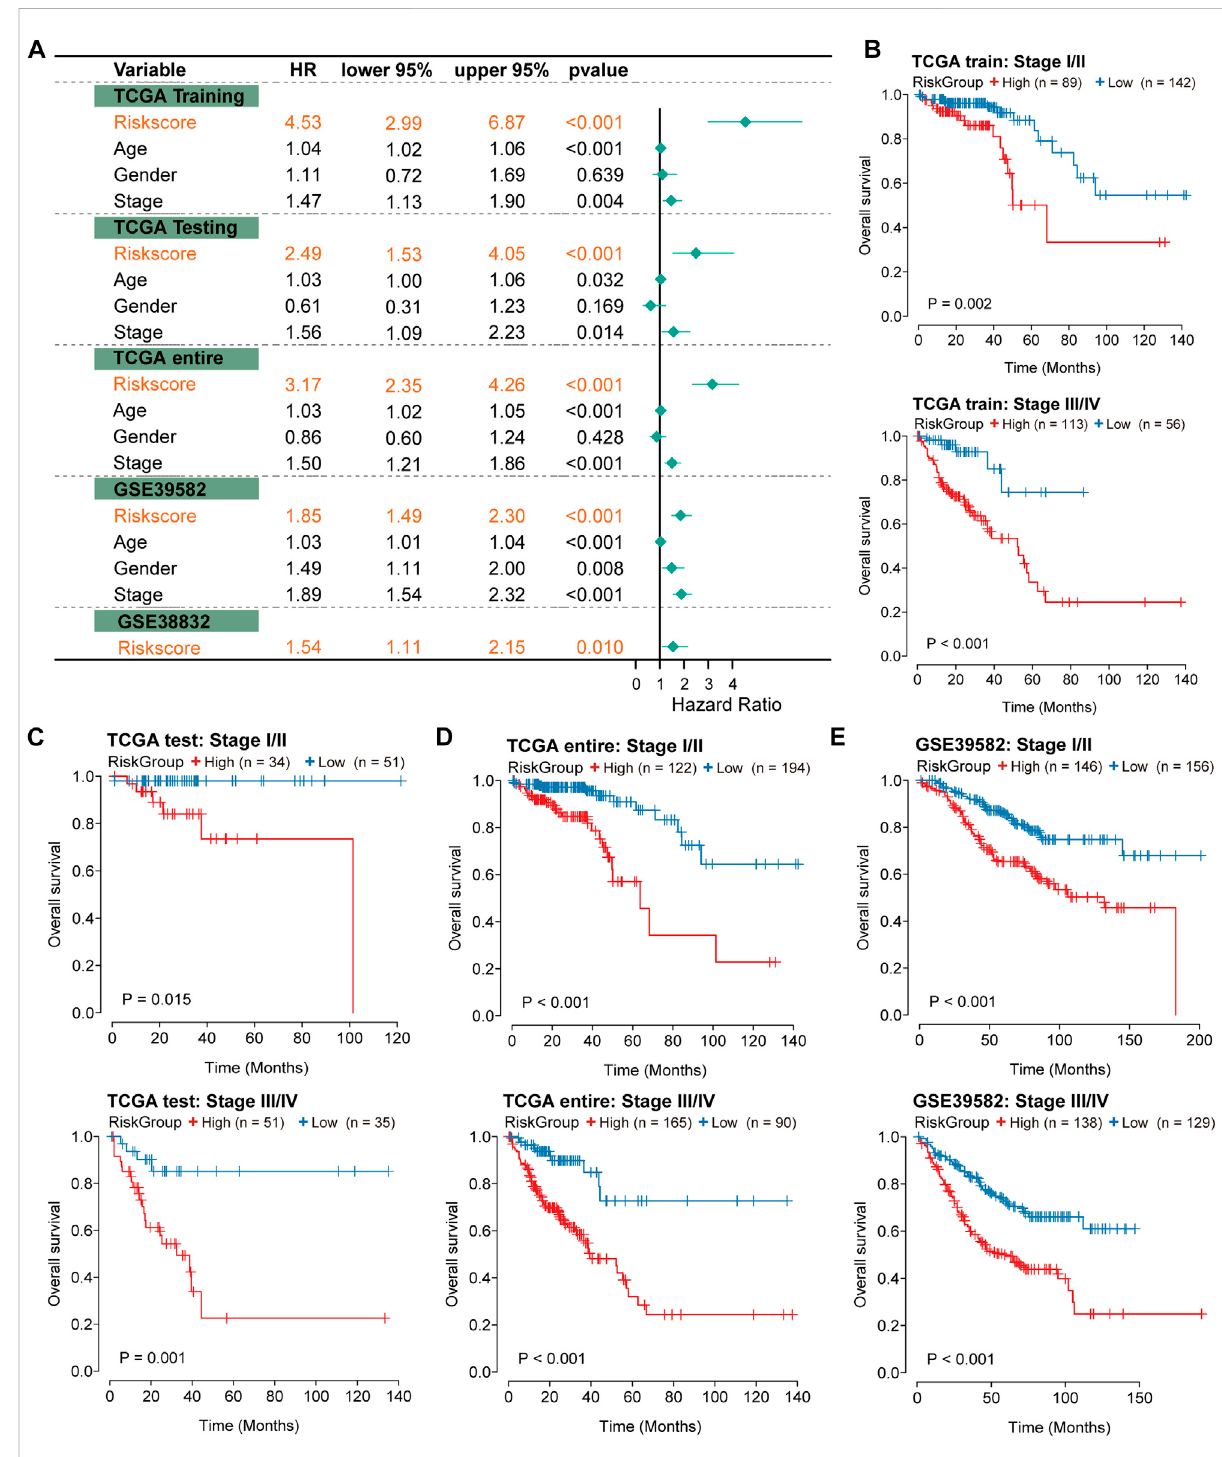
FIGURE 4 Independence of prognostic effect of the IRLncSig (A) Forest plot for the IRLncSig and other clinical factors by multivariate regression analysis. (B – E) Strati fi cation analysis by pathological stage. The p values were calculated by the Log-rank